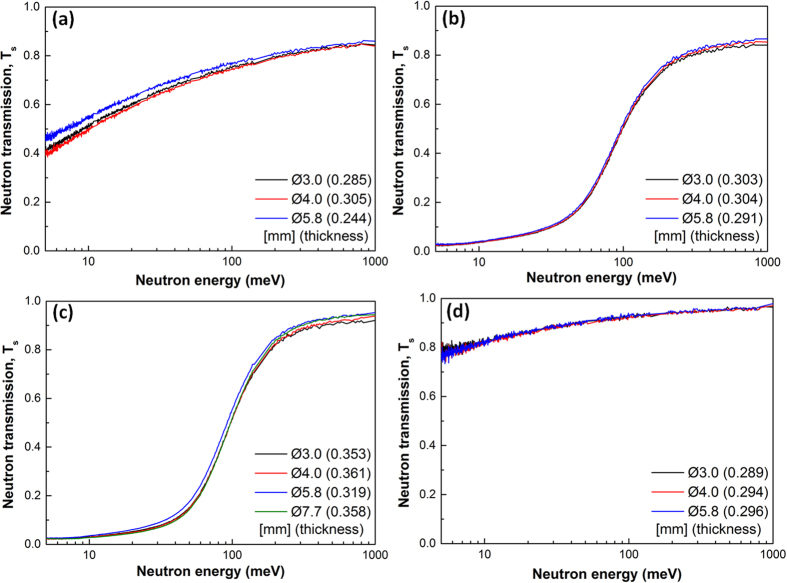
Measured neutron transmission in the neutron energy range of 5–1000 meV for different diameter disk samples with different thicknesses for four different alloys: (a) Fe-B16, (b) Fe-B15Gd2, (c) Fe-B6Gd2, and (d) Fe-B6Y2.